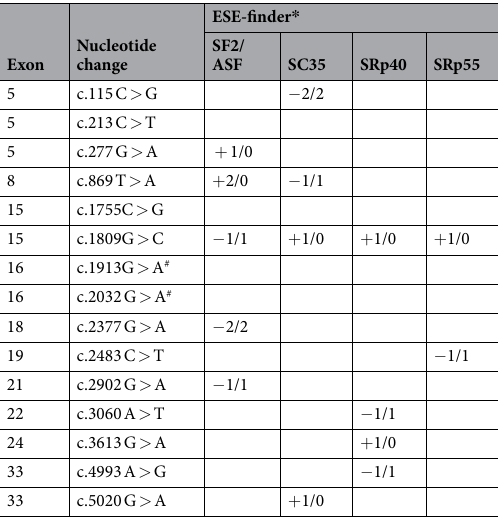
Table 4. Alterations of the putative ESE motifs with these variants detected in sporadic IPF patients and healthy controls. * Number of ESE motifs added or abrogated from the variant/number of ESE motifs in the normal allele; # The two variants were only detected in the healthy